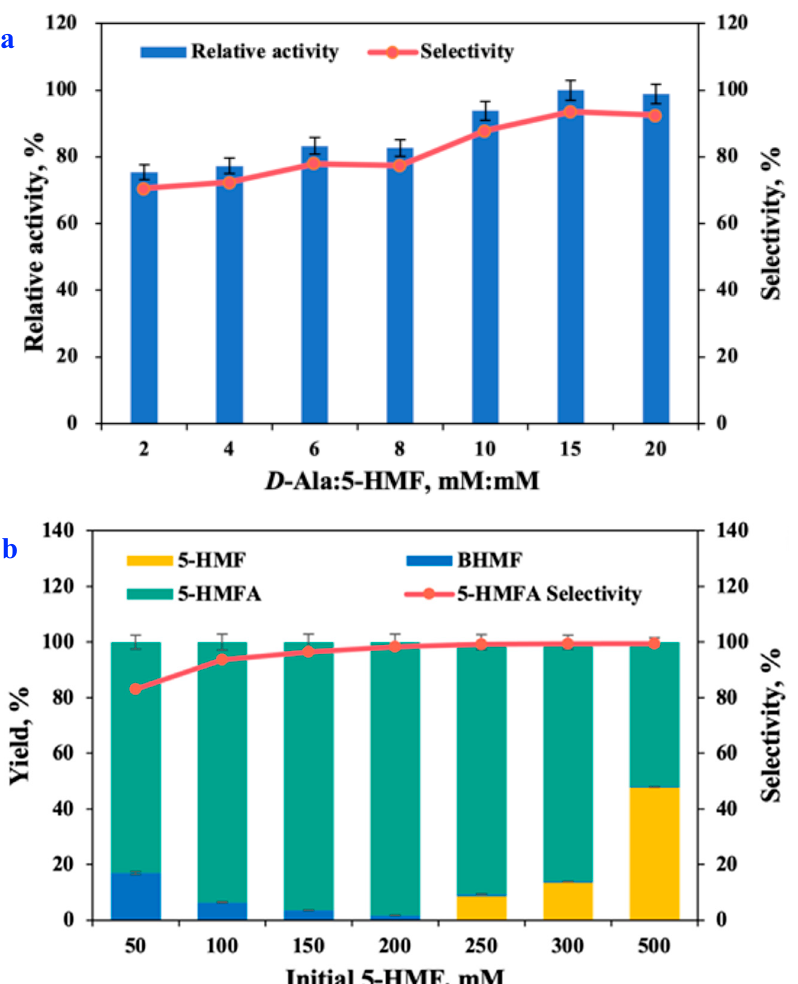
Figure 7. Effects of amine donor D -Ala dose (2:1–20:1 of D -Ala-to-5-HMF molar ratio) on the yield of 5-HMFA and selectivity [ E. coli AT 0.050 g/mL, 35 °C, pH 7.5] ( a ); Effects of initial 5-HMF dose (50–500 mM) on the 5-HMFA yield and selectivity [ E. coli AT 0.050 g/mL, 35 °C, pH 7.5, 15:1 of D -Ala-to-5-HMF molar ratio] ( b ).